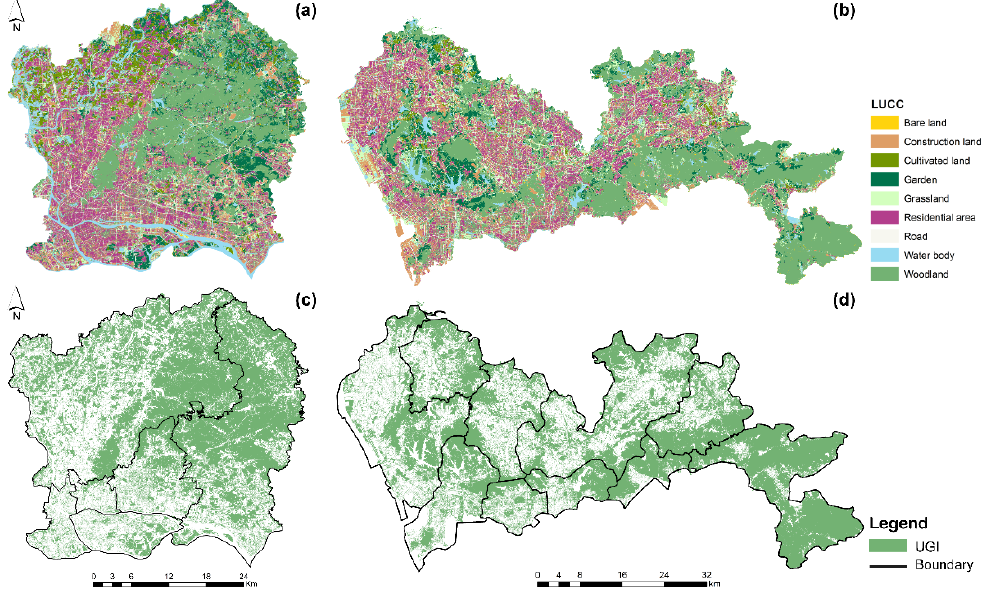
Figure 4. ( a ), ( b ) The land cover maps and ( c ), ( d ) UGI maps for ( a ), ( c ) Guangzhou central urban Figure 4. ( a , b ) The land cover maps and ( c , d ) UGI maps for ( a , c ) Guangzhou central urban district and ( b , d ) district and ( b ), ( d ) Shenzhen.